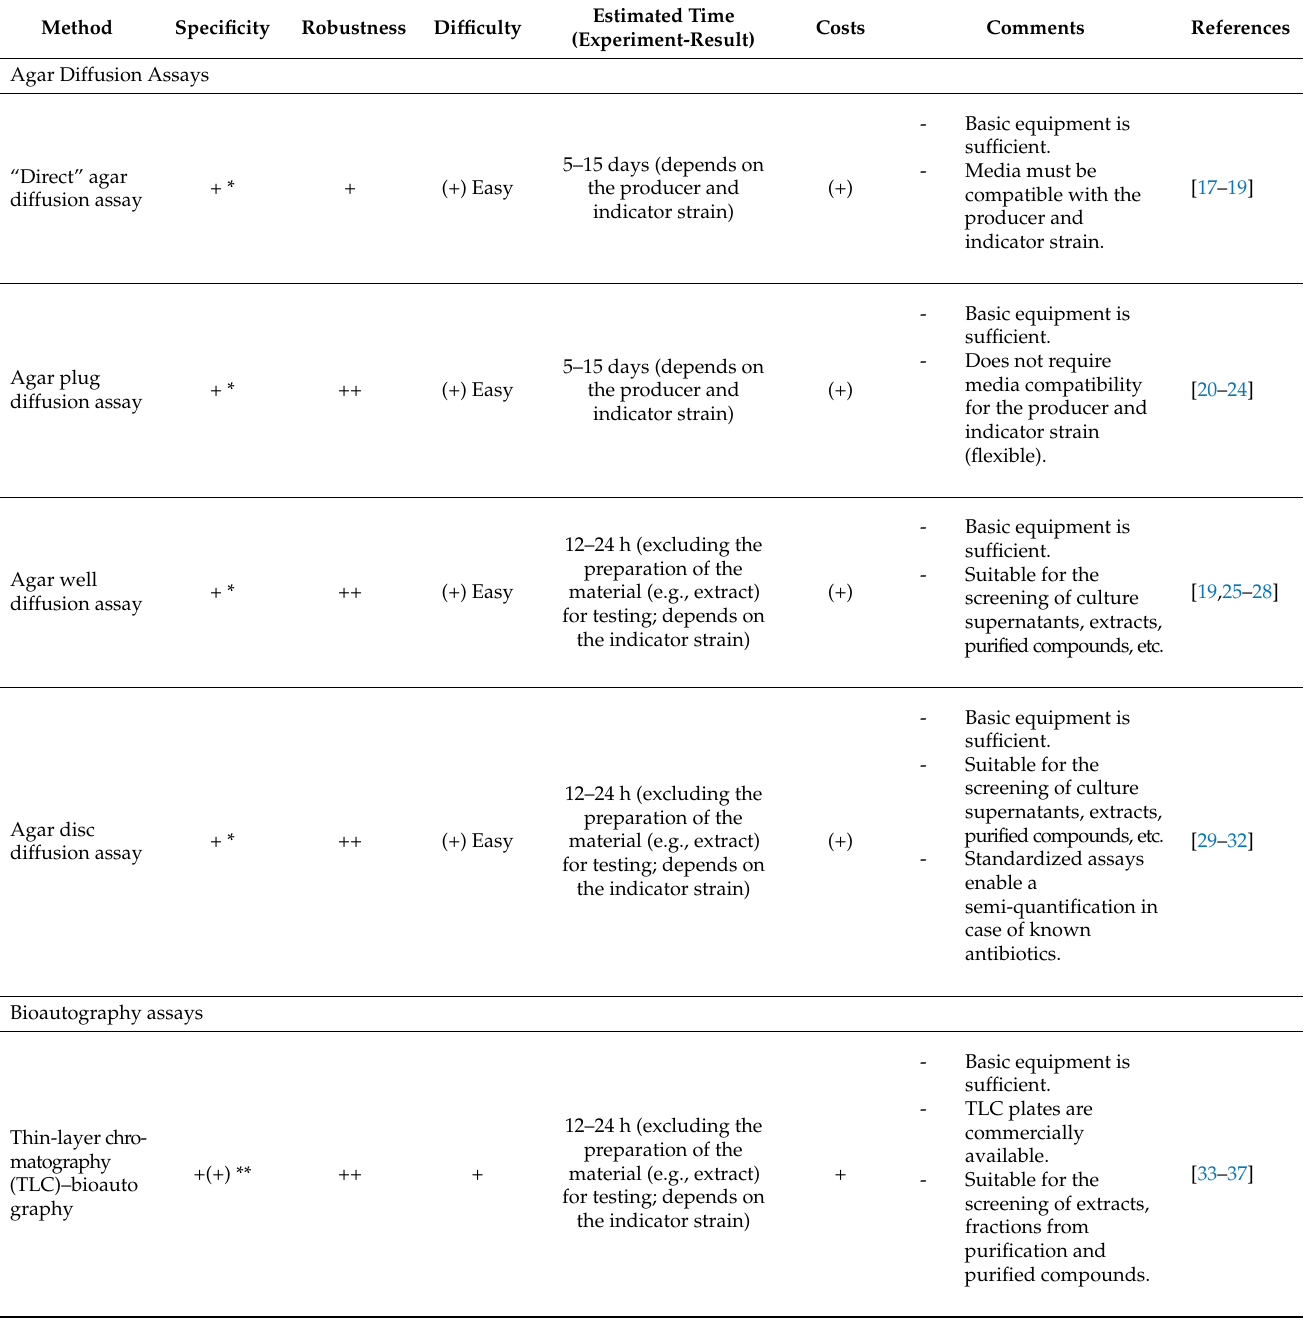
Table 1. Examples of diffusion- and bioautography-based assays for the detection of antimicrobial